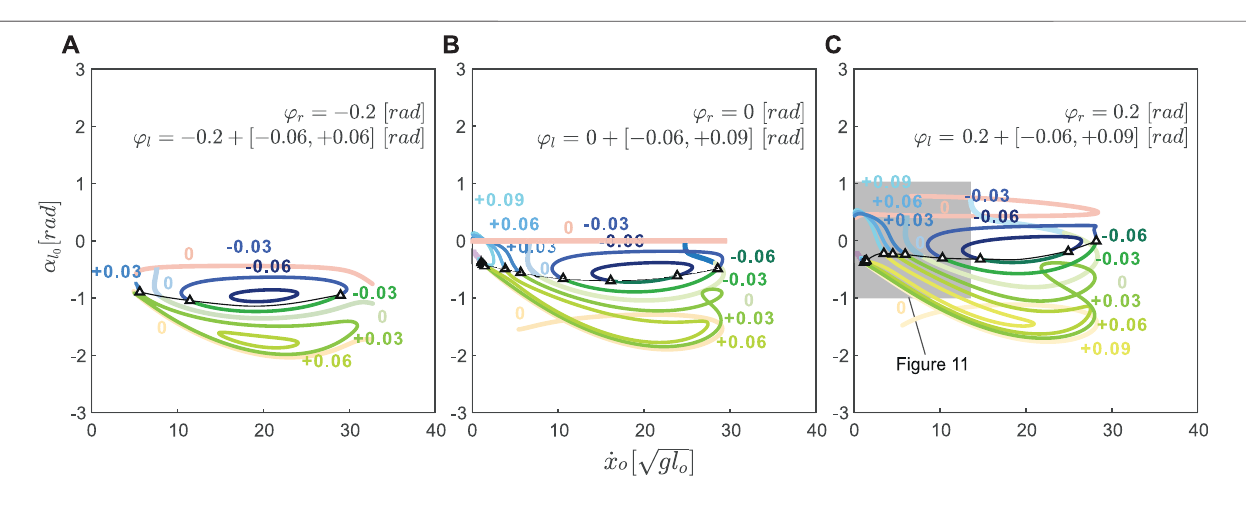
FIGURE9| The fi xedneutrallegswingangle, φ r ,andthevaryingneutrallegswingangle, φ l ,interacttoaffectasymmetrical gaitstructureinuncoupledmodels.Inall plots, the coupled φ l (cid:2) φ r ∈ [− 0 . 2 , 0 , + 0 . 2 ] rad gait structures are shown as transparent curves. In all cases, skipping and asymmetrical running spanned the gap between the hopping and symmetrical running branches. The gait transitions points (triangles) spanned almost the entire speed range. Comparing (A) , (B) , and (C) , demonstrates that gait structure varies greatly with neutral leg swing angle offset. The shadowed region in Figure 9C is shown in Figure 11 as a comparison between simulation solutions and experimental